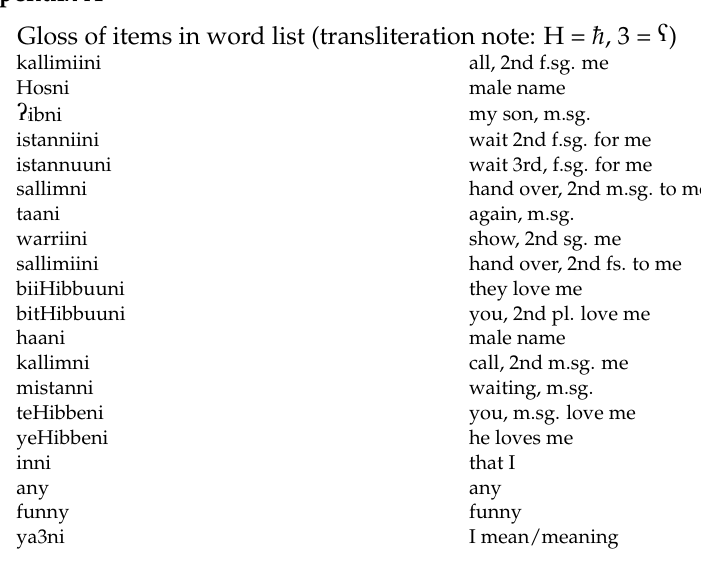
Table 1. Triggers of palatalization in Cairene (/t, d/ from Haeri 1996a, p. 51; Youssef 2015, pp. 25– 27; /n/ from my own informal observations).